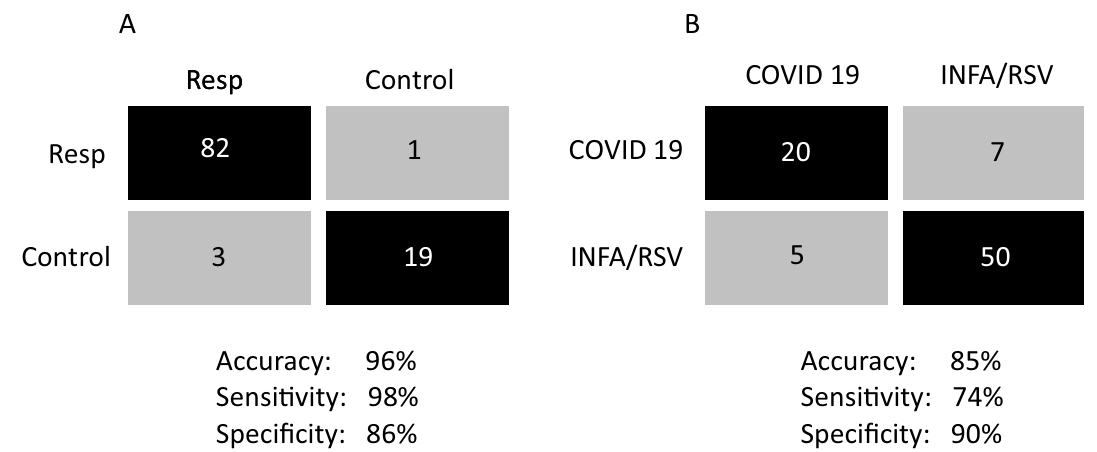
Figure 3. Confusion matrices based on test/train cohorts using 50% of the data. Shown in ( A ) and ( B ) from which the accuracy, sensitivity and specificity of identifying patients with a respiratory infection in general ( A ) or patients with COVID19 among patients with respiratory illness ( B ) was (Fig. 2A, B). A second model using orthogonal partial least squares discriminant analysis (OPLS-DA) focused on differences between all patients with respiratory illness (SARS-CoV-2, INFA and RSV) and unaffected con- trols, where the two groups appeared well-separated (Fig. 2C). Using half of the data for training and the other half for testing, this model had an accuracy of 96%, a sensitivity of 98% and specificity of 86% (R 2 = 0.771, Q 2 = 0.72) in differentiating between groups (Fig. 3A). Both training and testing sets exhibited area-under the curve measurements based on receiver operating characteristic curves of > 0.90, shown in the Supplementary Methods (AUROC; training = 0.98, testing = 0.91). A third model compared COVID19 patients and those with other respiratory illnesses (INFA or RSV) (Fig. 2D) Using the same cross-validation analysis as above, this model distinguished COVID19 from other patients with an accuracy of 85%, sensitivity of 74% and specificity